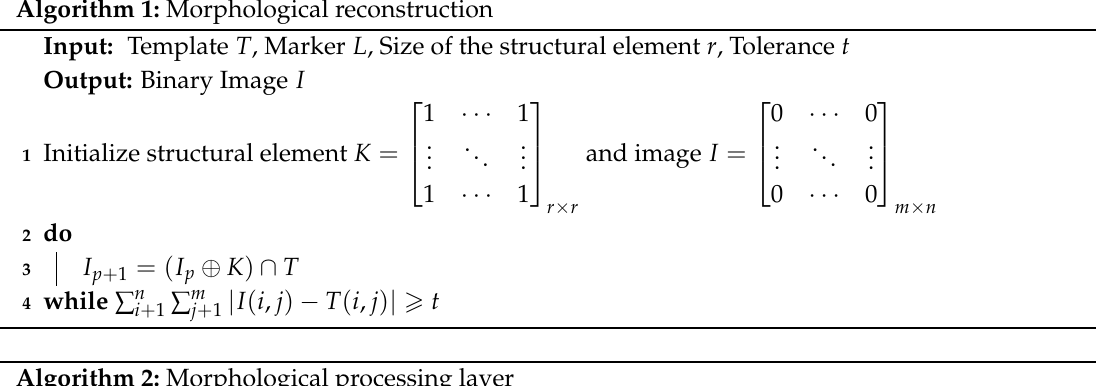
Algorithm 2: Morphological processing